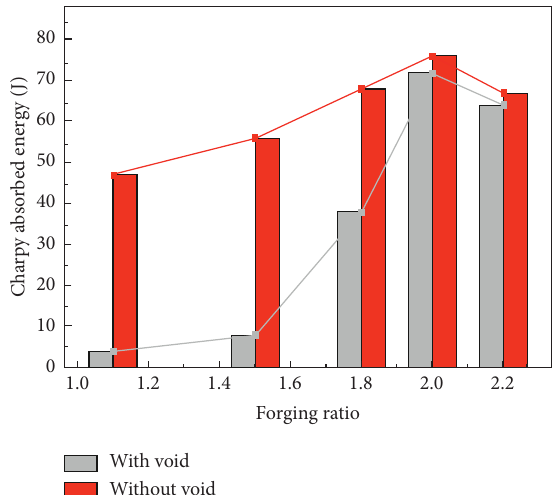
Figure 11: Changes of impact properties in the crack healing area at different values of